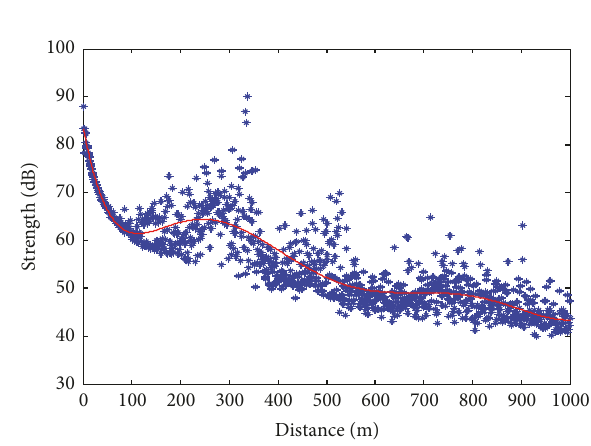
Figure 4: Mobile simulation